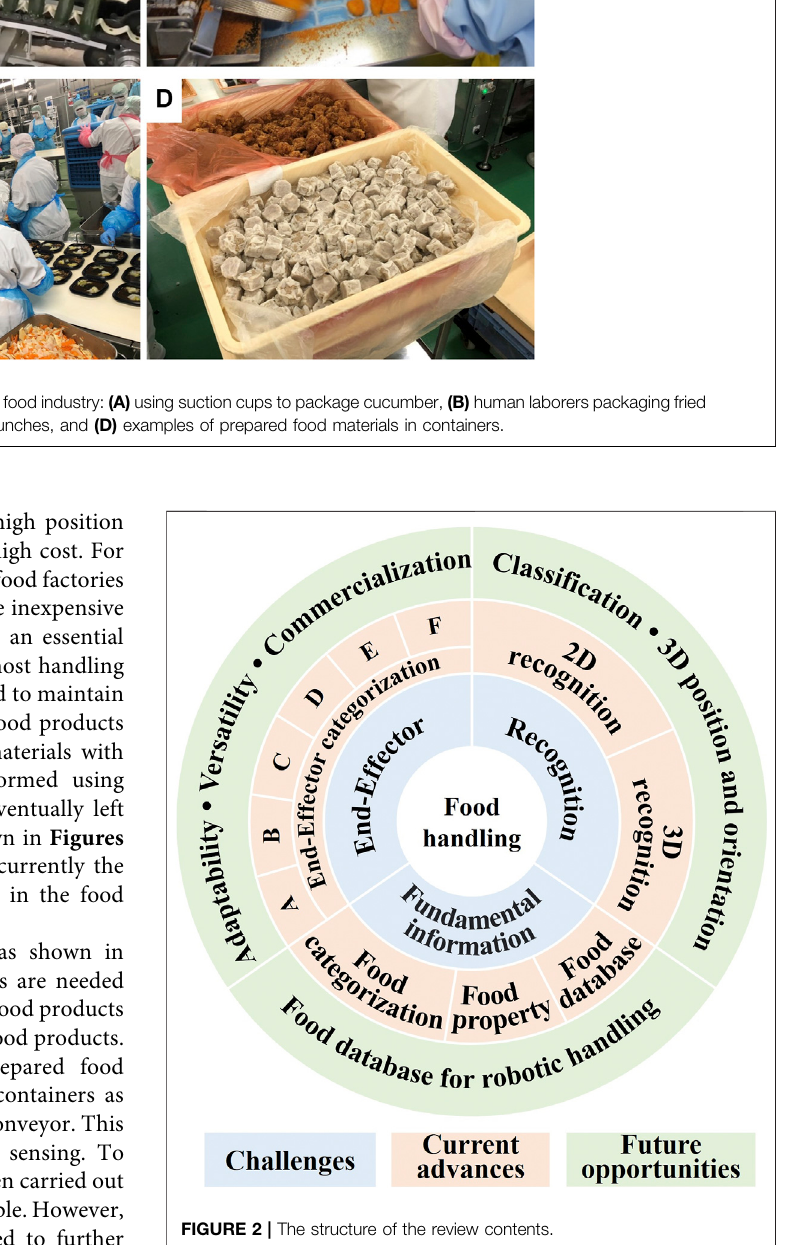
FIGURE 2 | The structure of the review